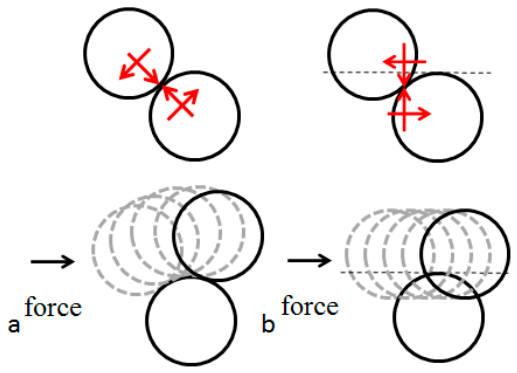
Figure 3. Kinematic models. ( a ) The FJM. ( b ) The SJM.